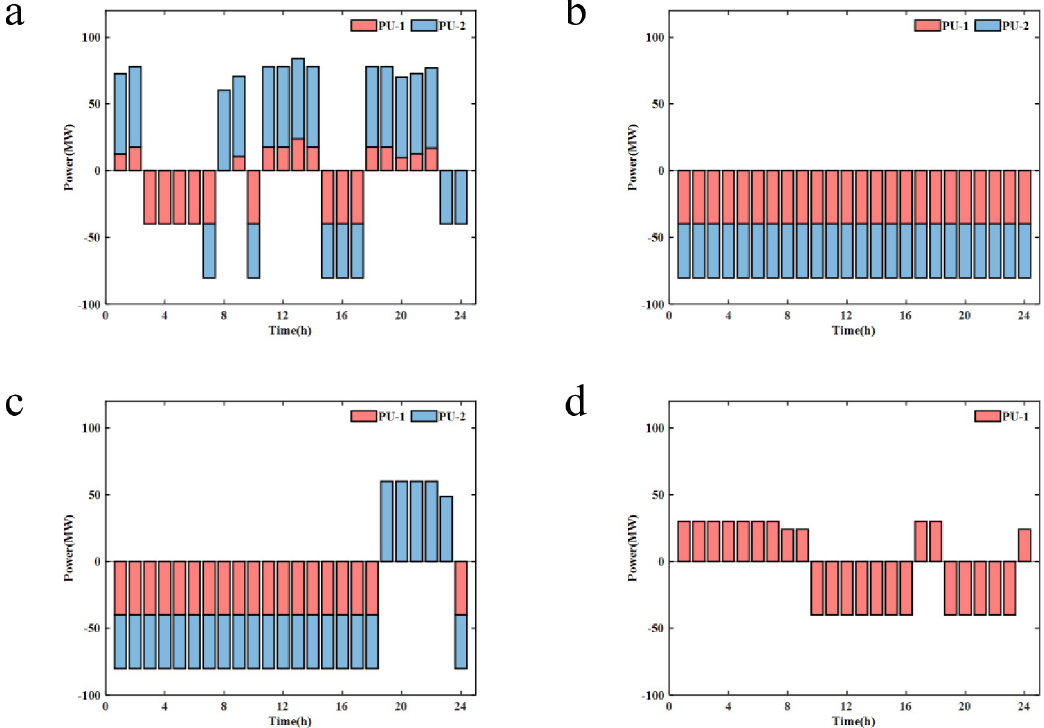
Fig 6. Output of pumped storage power station in Cases 2–4 (a) Output of pumped storage power station 1 in Case 2, (b) Output of pumped storage power station 1 in Case 3, (c) Output of pumped storage power station 1 in Case 4, (d) Output of pumped storage power station 2 in Case